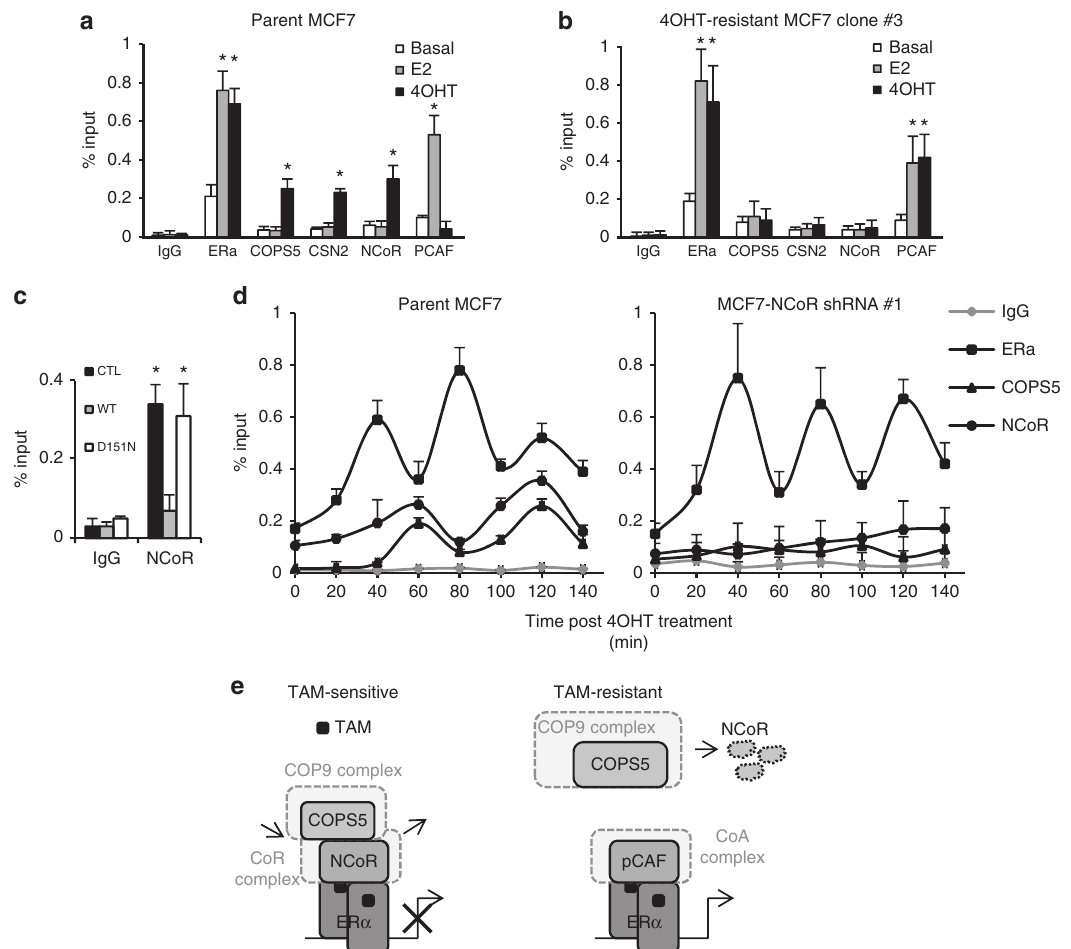
Figure 6 | COPS5 overexpression alters the dynamics of coregulator exchange on the pS2 promoter. ChIP analysis of the pS2 promoter occupancy of ER a , COPS5, CSN2, NCoR and PCAF on stimulation with ER a ligands for 2h in ( a ) parental MCF7 cells and ( b ) 4OHT-resistant MCF7 clone #3. E2, 1nM; 4OHT, 1 m M. Data are presented as mean þ s.e.m. from three independent experiments. *Significant difference compared with corresponding basal recruitment ( P o 0.01, Student’s t -test). ( c ) ChIP analysis of NCoR on stimulation with ER a ligands for 2h in parental and engineered COPS5-overexpression MCF7 cells. *Significant difference compared with corresponding basal recruitment ( P o 0.01, Student’s t -test). ( d ) Kinetic ChIP analysis of ER a , COPS5 and NCoR on the pS2 promoter at 20-min interval in parental MCF7 or NCoR shRNA #1 cells. Data are presented as mean þ s.d. from two independent experiments. ( e ) A schematic representation of the proposed molecular model of functional interactions between COPS5 and NCoR in ER a -dependent transcription based on the ChIP data (see text for details). TAM,